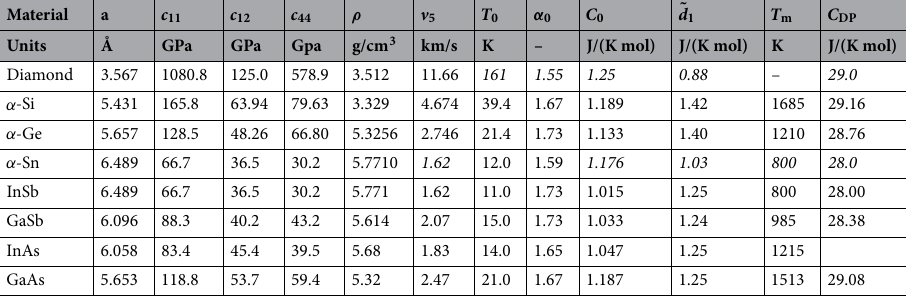
Table 1. Physical properties of the carbon group elements and the zinc-blend